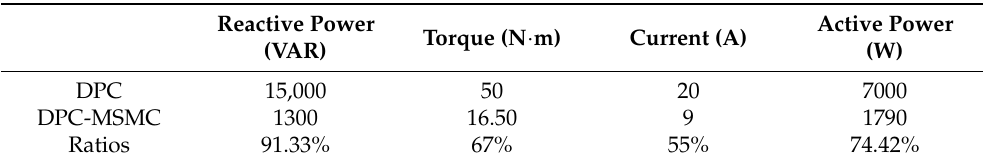
Table 5. Comparison of ripple values between the designed and the traditional DPC technique (variable speed wind test).